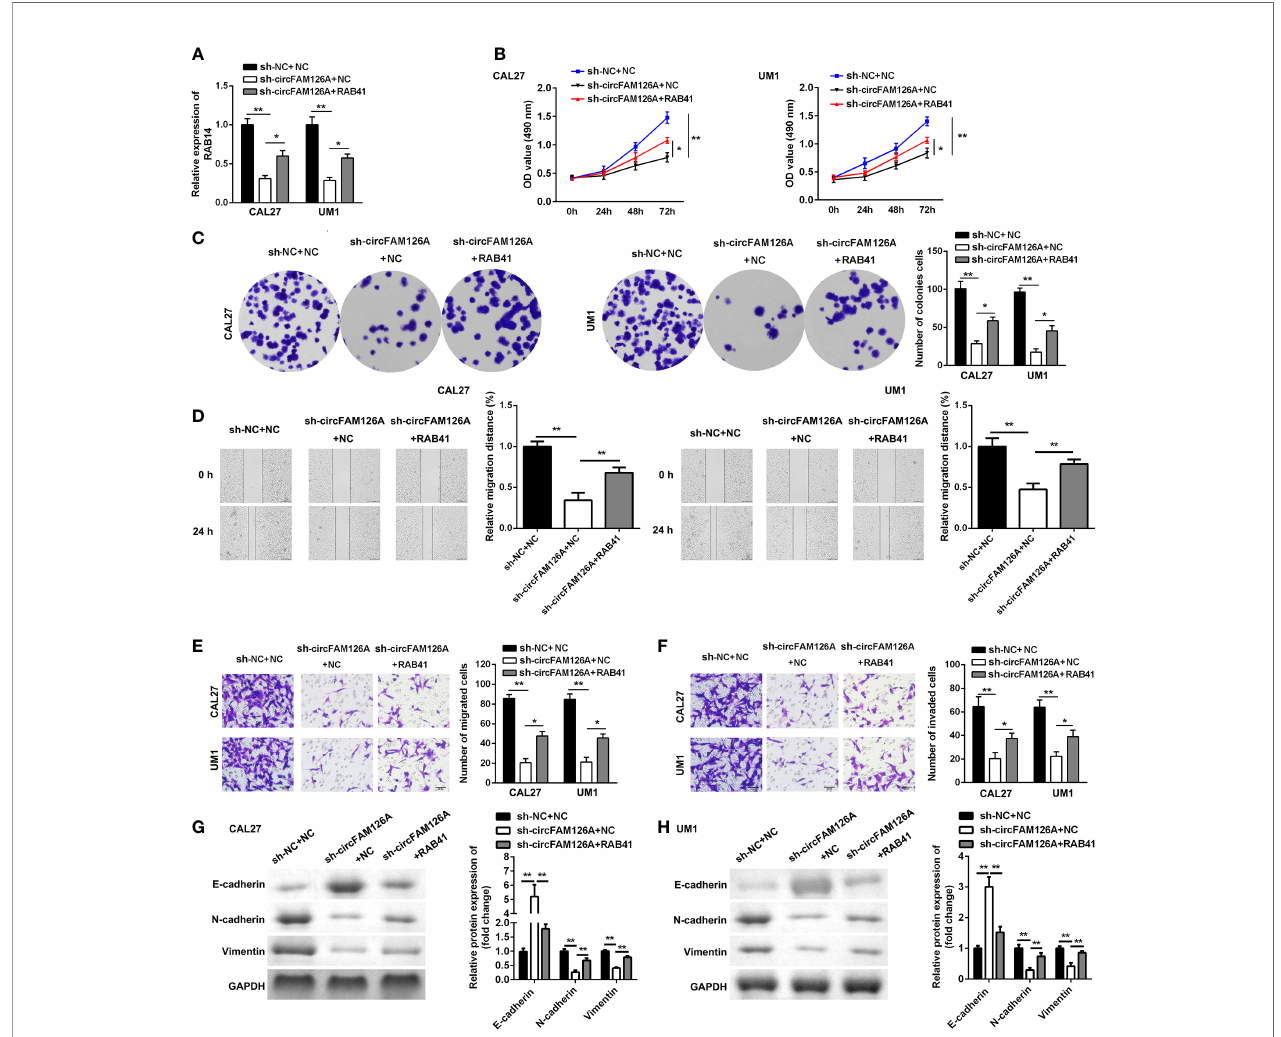
FIGURE 8 | Overexpression of RAB41 reverses the anti-tumor effects of sh-circFAM126A. (A) Expression of RAB41 in OSCC cells detected using qRT- PCR. (B, C) Viability and proliferation ability of OSCC cells detected by MTT and colony formation assay. (D) . Migration determined using wound healing assay. (E, F) Migration and invasion ability of OSCC cells measured using transwell assay. (G, H) Protein expressed determined using western blot. * P < 0.05, ** P <